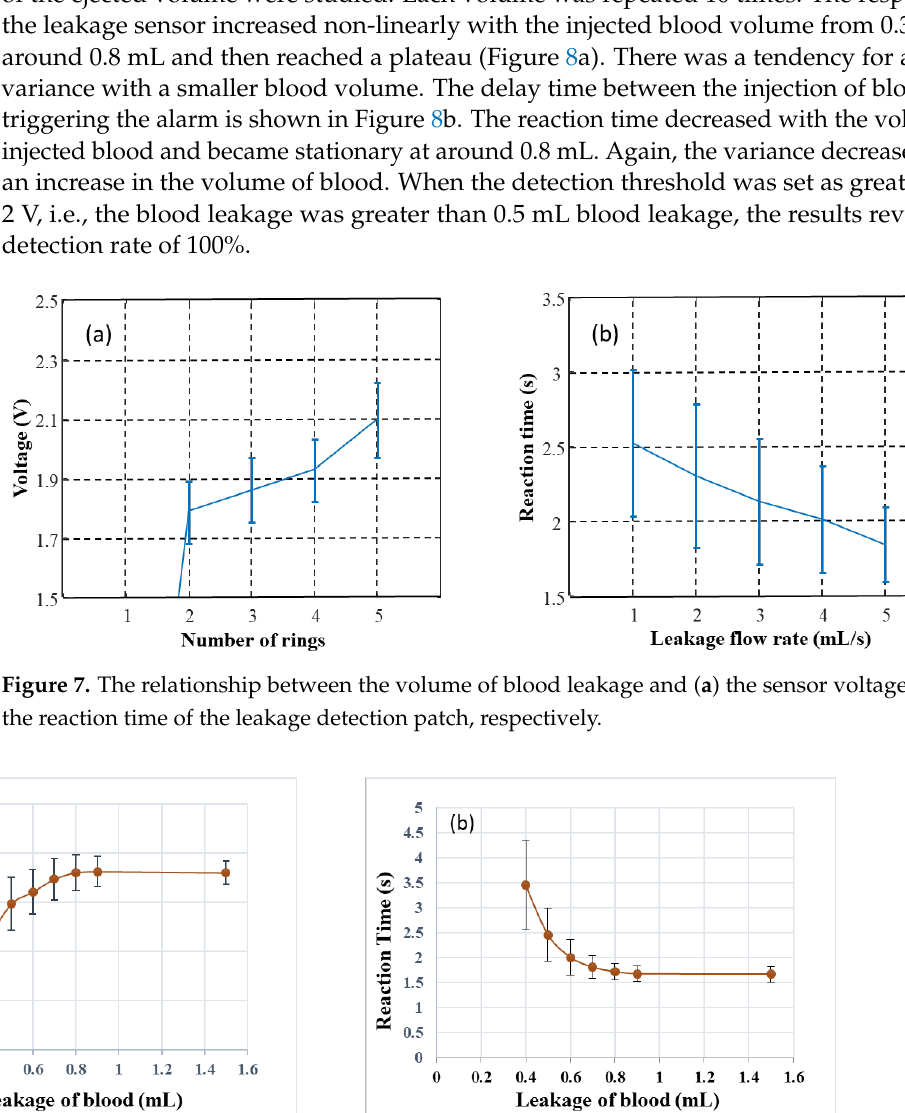
Table 1. Characteristics of the enrolled hemodialysis patients.